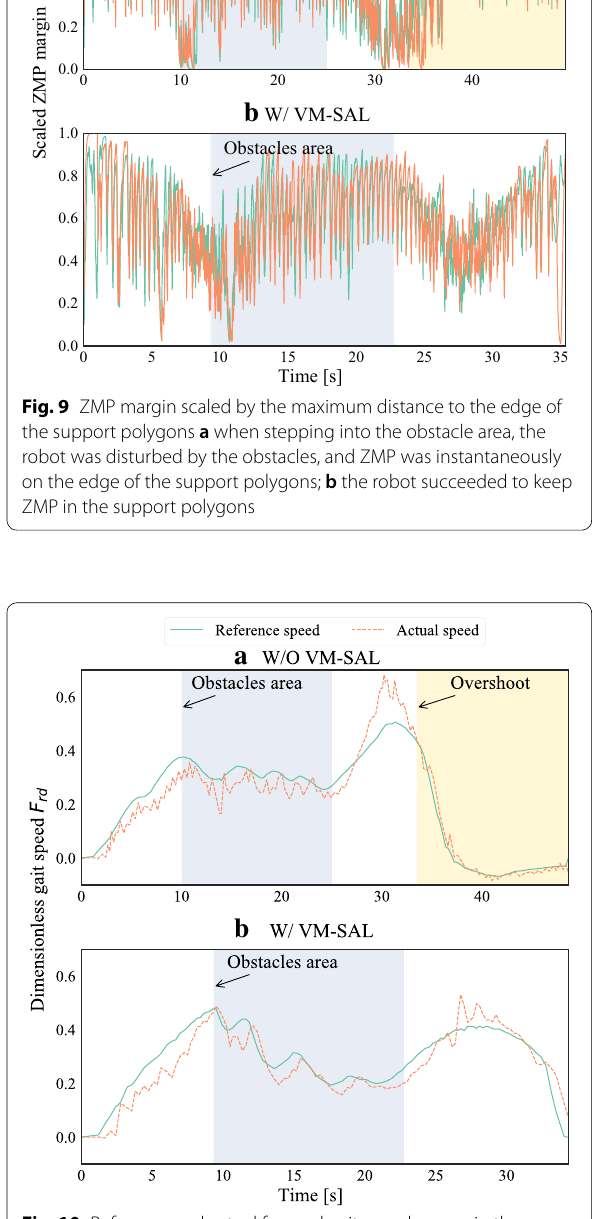
Fig. 10 Reference and actual forward gait speed a even in the obstacles area, the gait speed was hardly decreased, which caused oscillation of actual gait speed; the robot could not brake its speed on the goal, and wasted about 16 s to reach the goal; b in the first stable area, the gait speed was rapidly accelerated to prioritize efficiency; in the obstacles area, the robot braked to prioritize stability